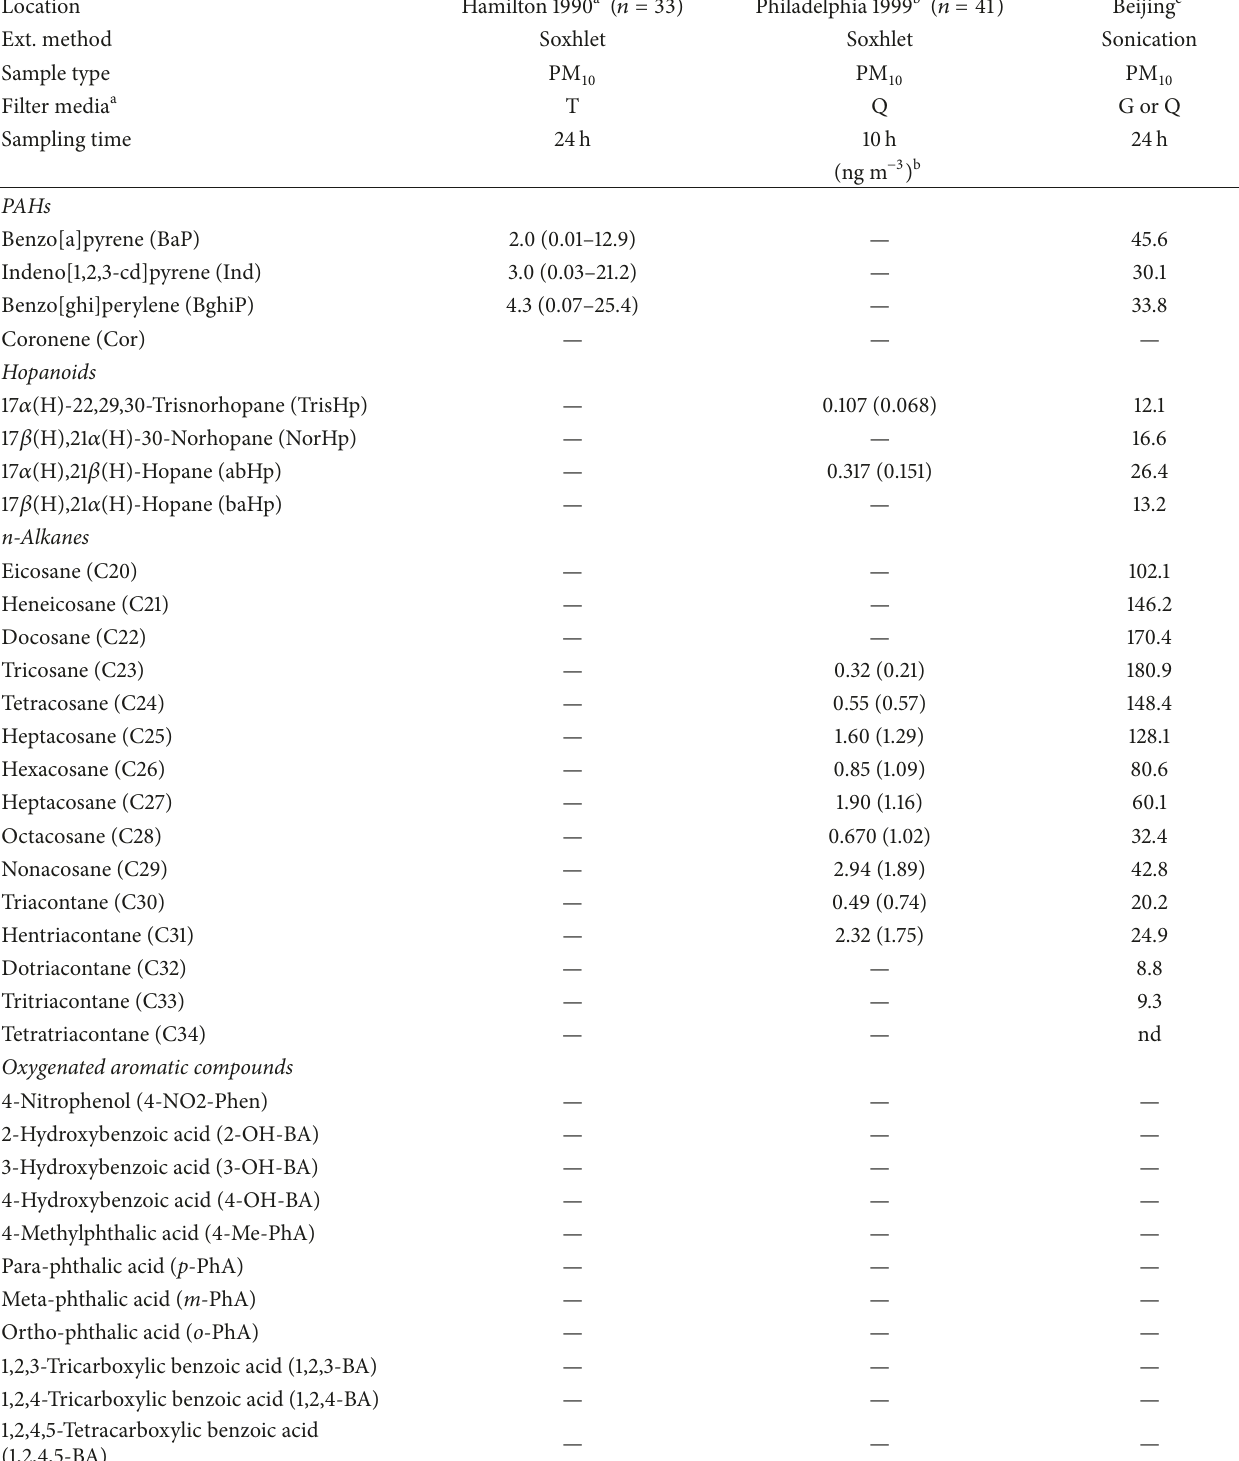
Table 2: Molecular marker concentrations observed in other